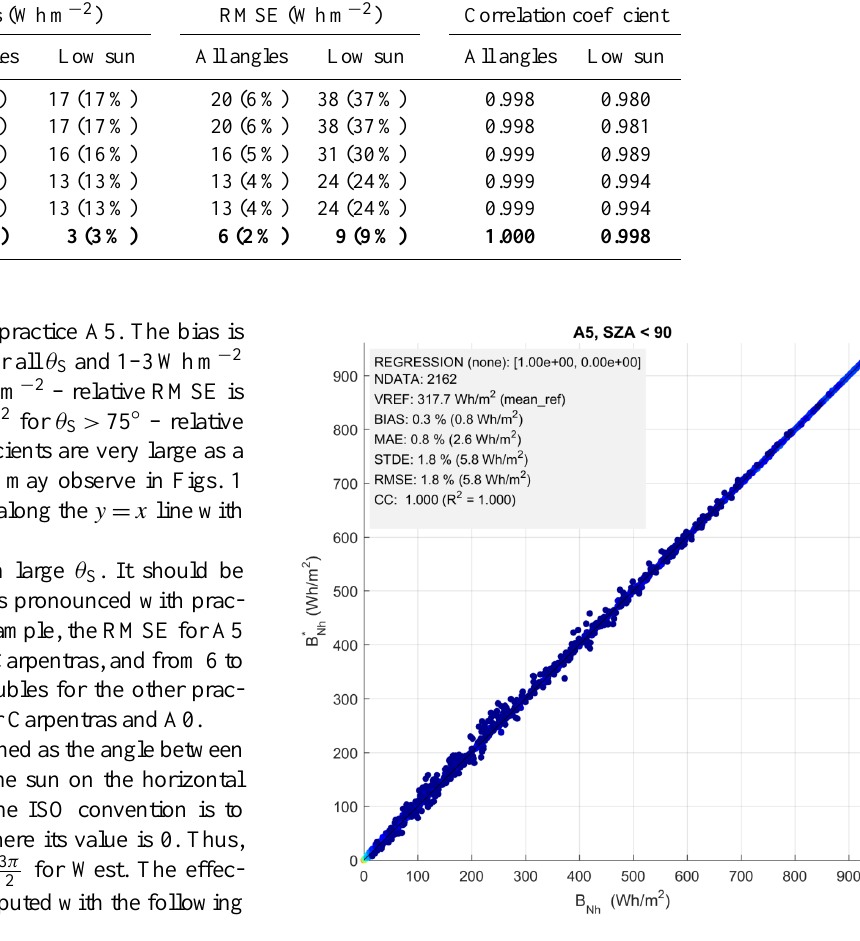
Figure 3. Correlogram between B Nh (horizontal axis) and B ∗ (vertical axis) for all solar zenith an- computed with θ eff,A5 S gles (SZA) for